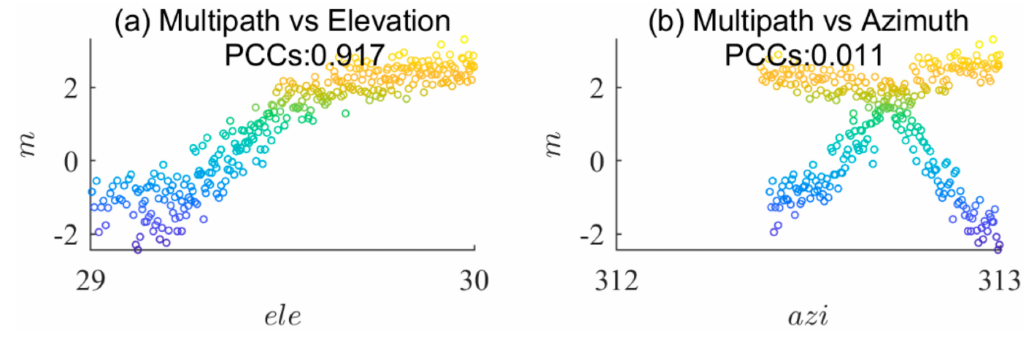
Figure 4. The multipath error varies closely with the elevation in grid (30, 313). ( a ) Correlation between the elevation and multipath. ( b ) Correlation between the azimuth and multipath. X-axis unit: degree, Y-axis unit: meter. Pearson correlation coe ffi cient (PCC).